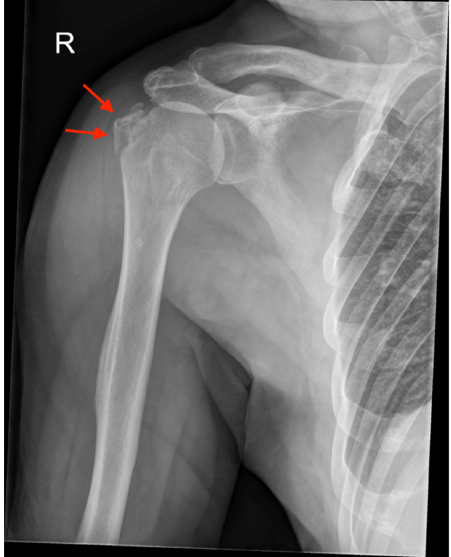
Figure 2. Plain radiography of the right shoulder with inferior dislocation after reduction: the greater tuberosity is fractured and nearly undisplaced after reduction (red arrows).